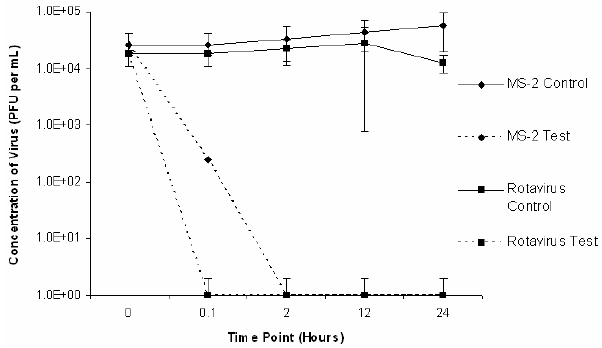
Figure 3: Rotavirus Wa and MS2 persistence in a test lime and control RO water matrix at room temperature (22 ± 5°C).